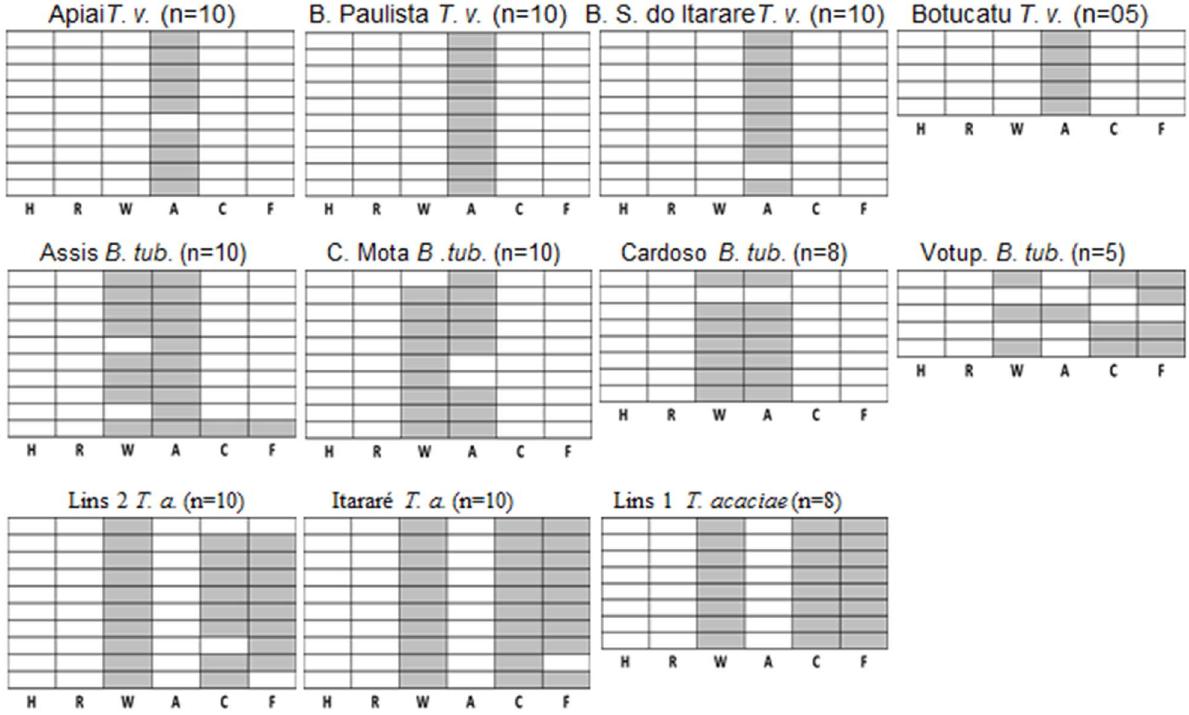
Figure 2. Individual and mixed infections with secondary endosymbionts in additional whitefly species analyzed in this study. Four populations of T. vaporariorum (T. v.) , 4 populations of B. tuberculata ( B. tub.) and 3 populations of T. acaciae ( T. a.) were collected and analyzed in this study (See legend to figure 2 for more details).